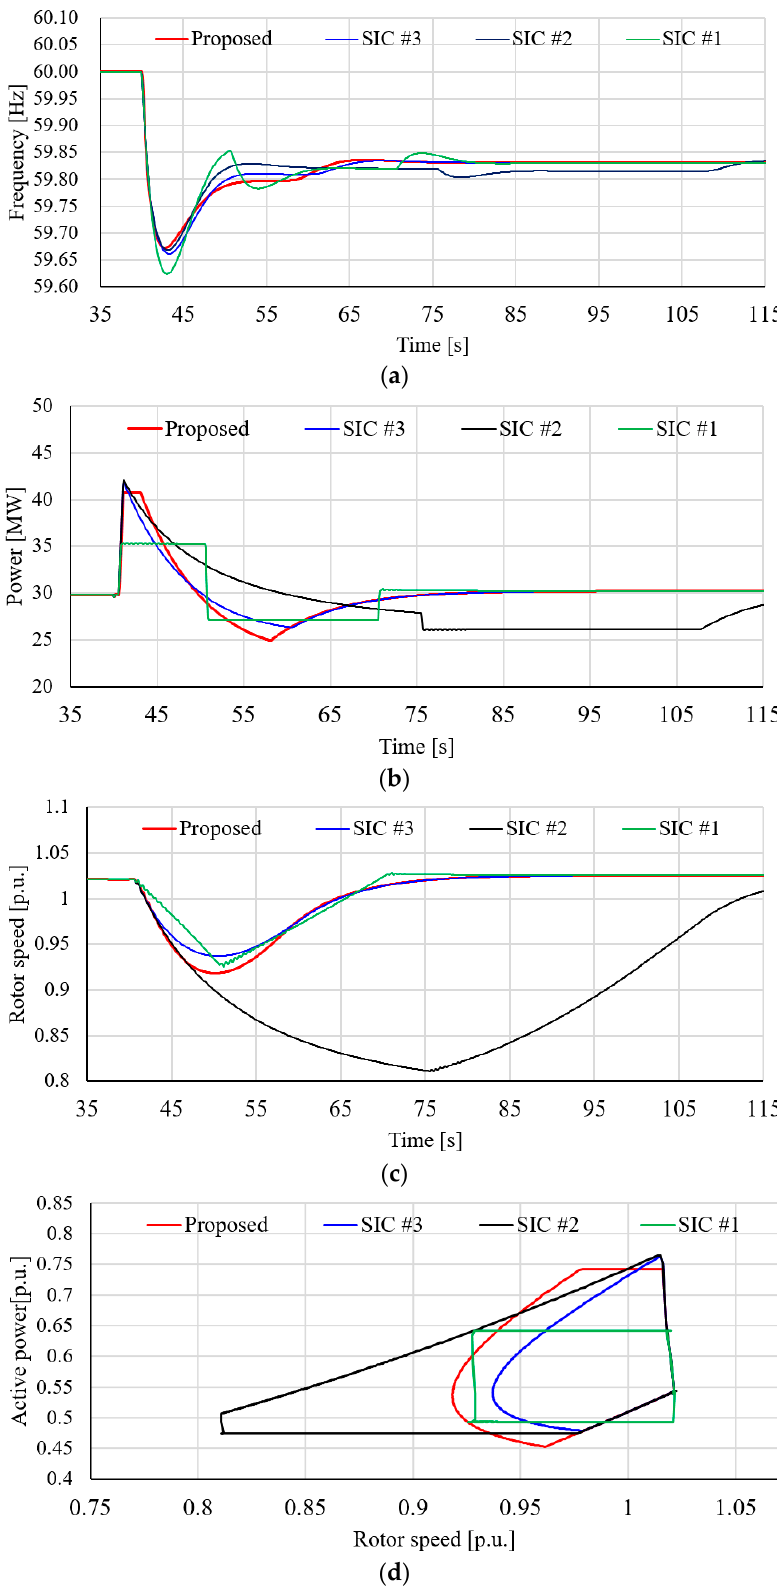
Figure 9. Results for Case 2. ( a ) System frequency; ( b ) Output power of the wind farm; ( c ) Rotor speed; ( d ) Output power in the rotor speed domain.